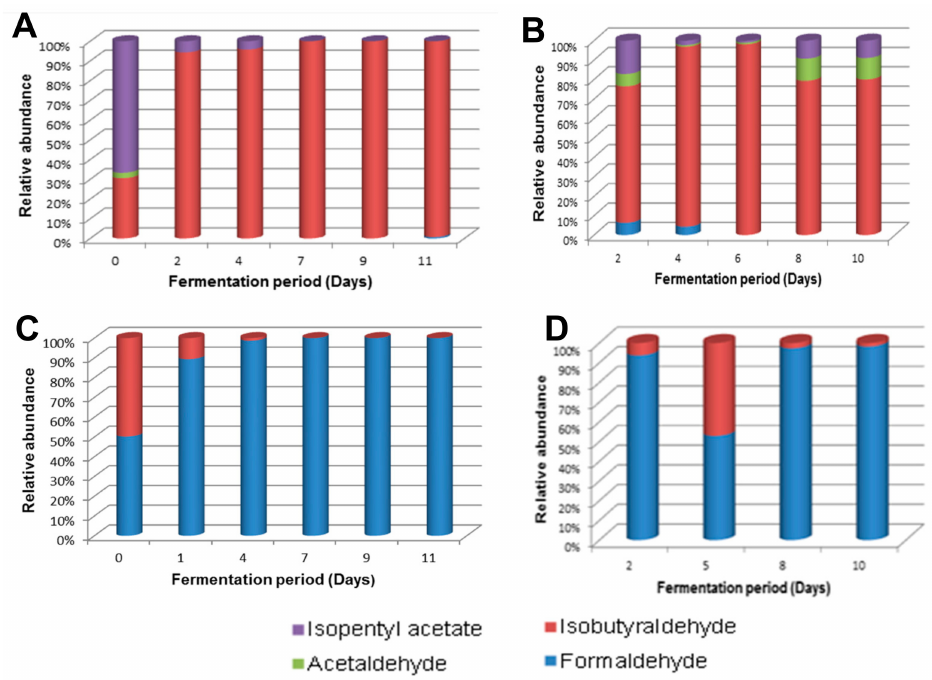
Figure 8. Aldehydes and esters during fermentation of marula wine from ( A ) Lab, ( B ) Mentz, ( C ) Moshira-A and ( D )